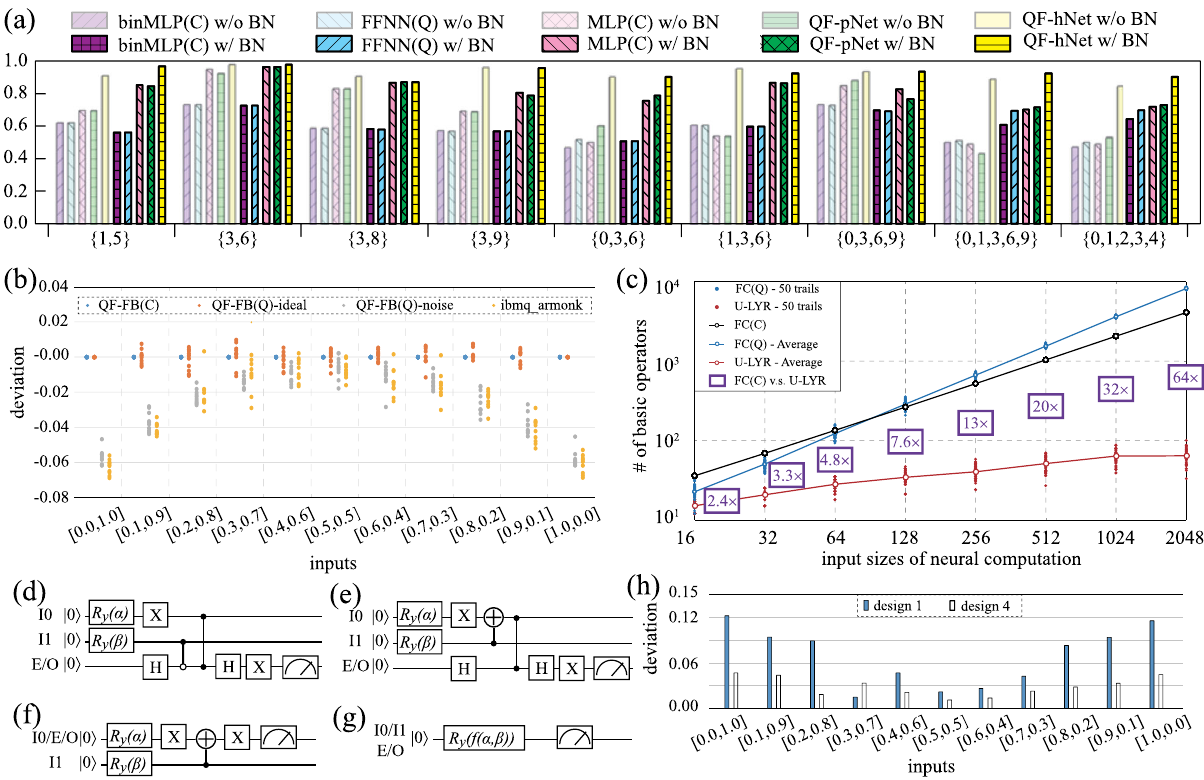
Fig. 2 Experimental results. a QF-hNet achieves state-of-the-art accuracy in image classi fi cations on different sub-datasets of MNIST. b Output probability comparison on QF-FB(C), QF-F(Q)-ideal which assumes perfect qubits, QF-F(Q)-noise which applies noise model to “ ibm_armonk ” backend of IBM quantum processor, and results of circuit design ( “ design 4 ” ) in sub fi gure (i) on the same backend. c Demonstration of Quantum Advantage achieved by U-LYR in QuantumFlow: comparison is conducted by using 50 random generated weights for each input size. d Design 1 for a two-input neural computation, which follows the original neural computation design. e – g Three optimized designs (design 2 – 4), based on design 1. h The deviation of